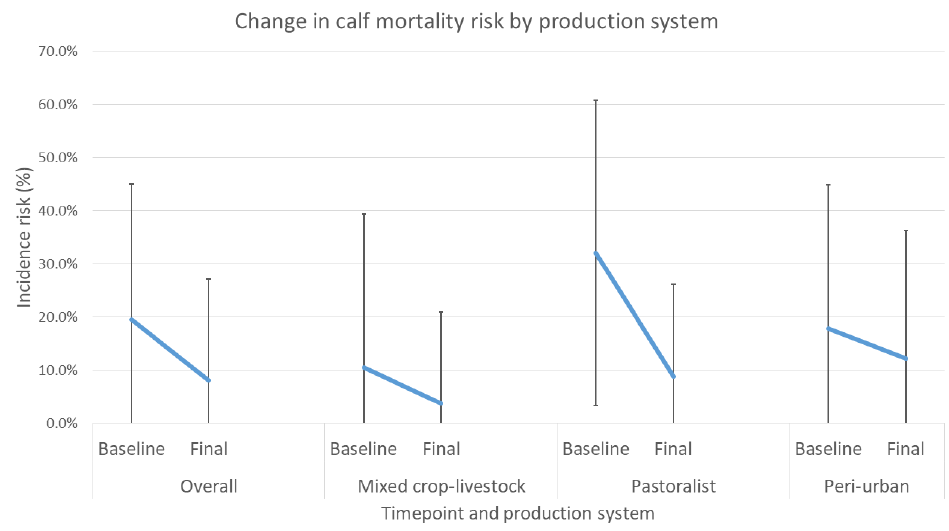
Figure 6. Change in average mortality risk in calves between baseline and final overall evaluation and for each production system with standard deviation bars.